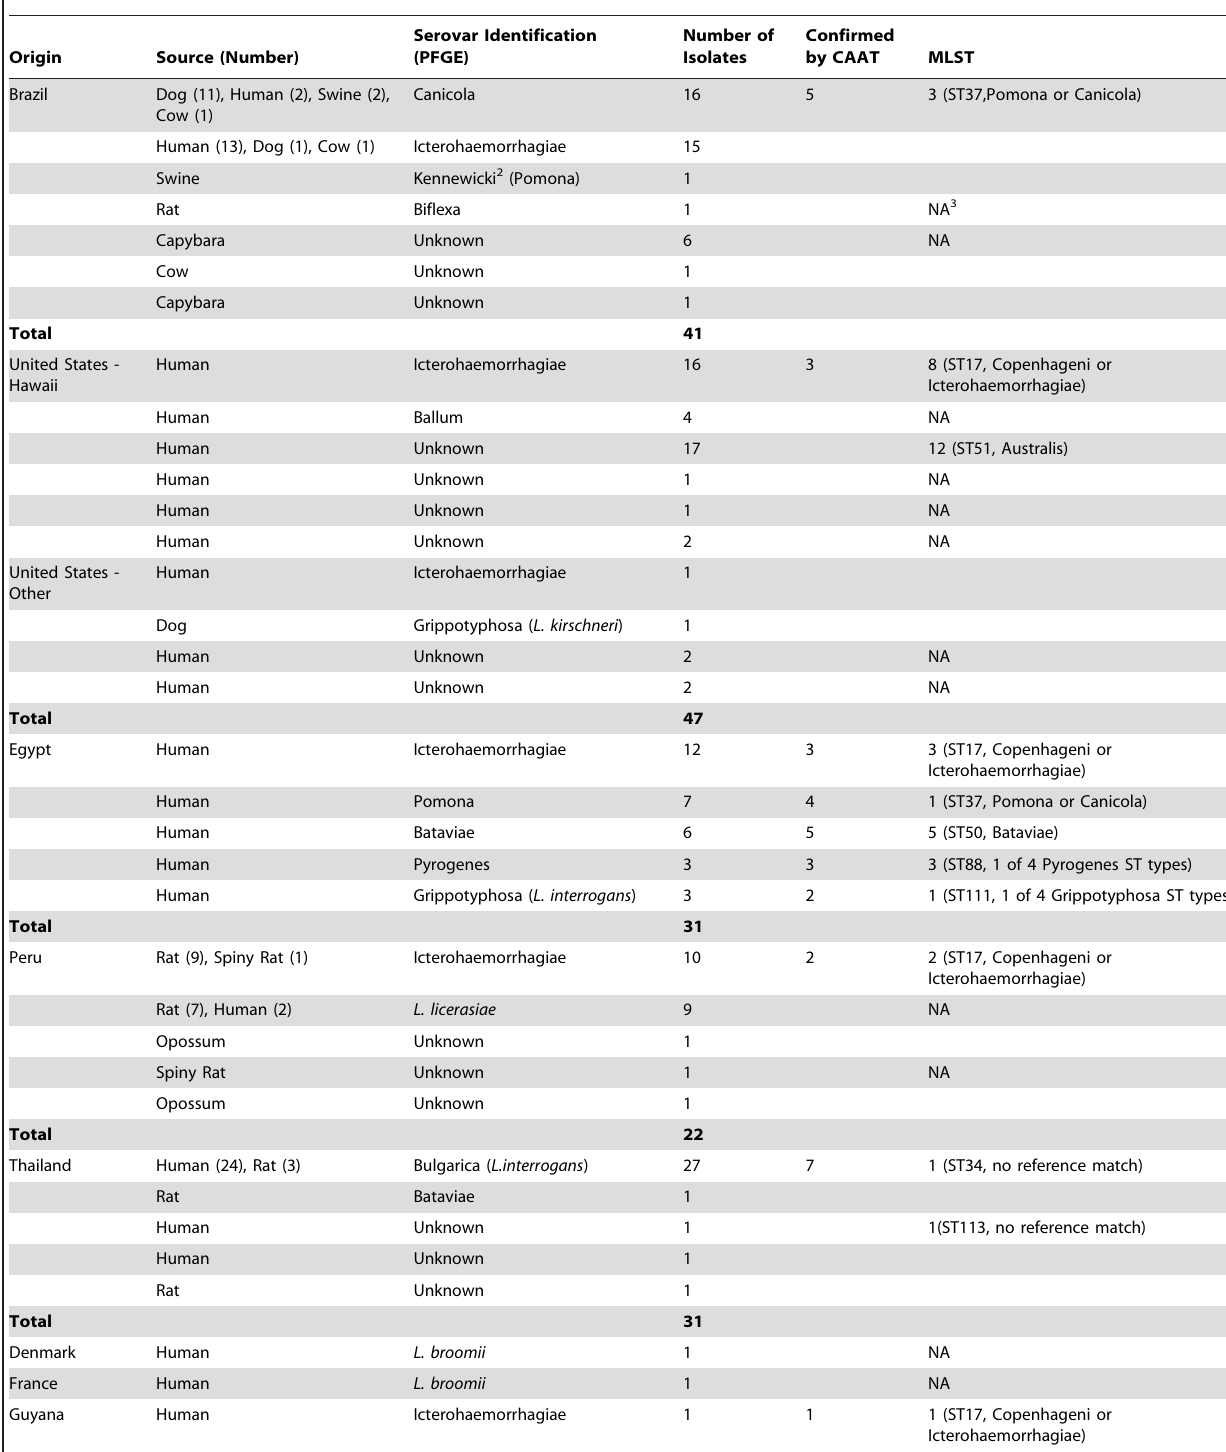
Table 1. Serovar identification results and CAAT results of isolates sent to CDC.